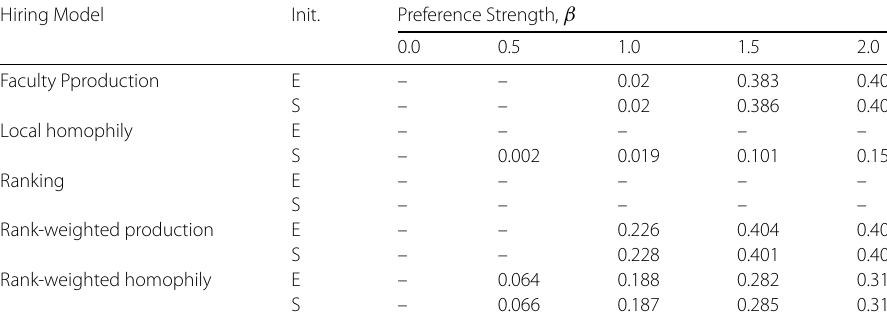
Table S3 Best-fit values of the random hiring parameter p for the Computer Science faculty hiring network. Each entry in the table presents the value of p that minimized the distance between modeled networks and empirical networks for values of preference strength β , initializations (E, Egalitarian; S, Skewed) and hiring models, as shown. For combinations which were unable to plausibly reproduce the properties of empirical networks ( D > 0.1, see Methods), no value of p is given Hiring Model Init.